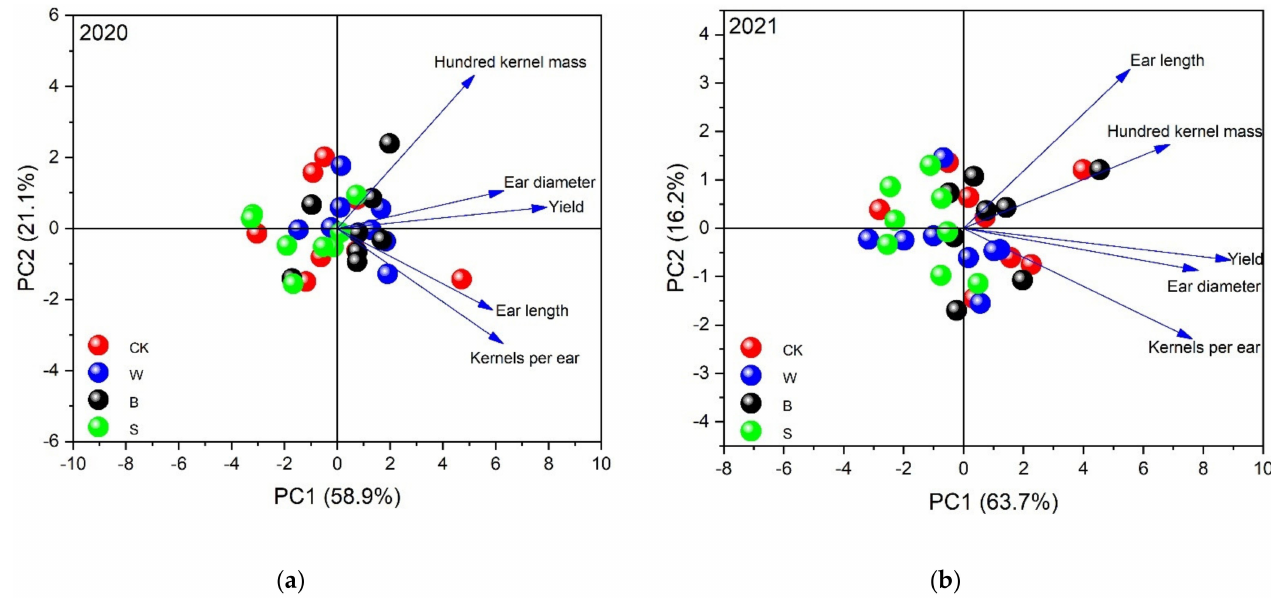
Figure 4. Principal component analysis of yield components in 2020 ( a ) and 2021 ( b ).